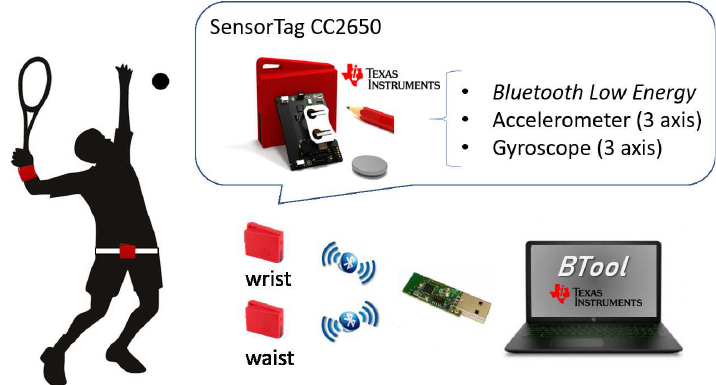
Figure 5. Sensors